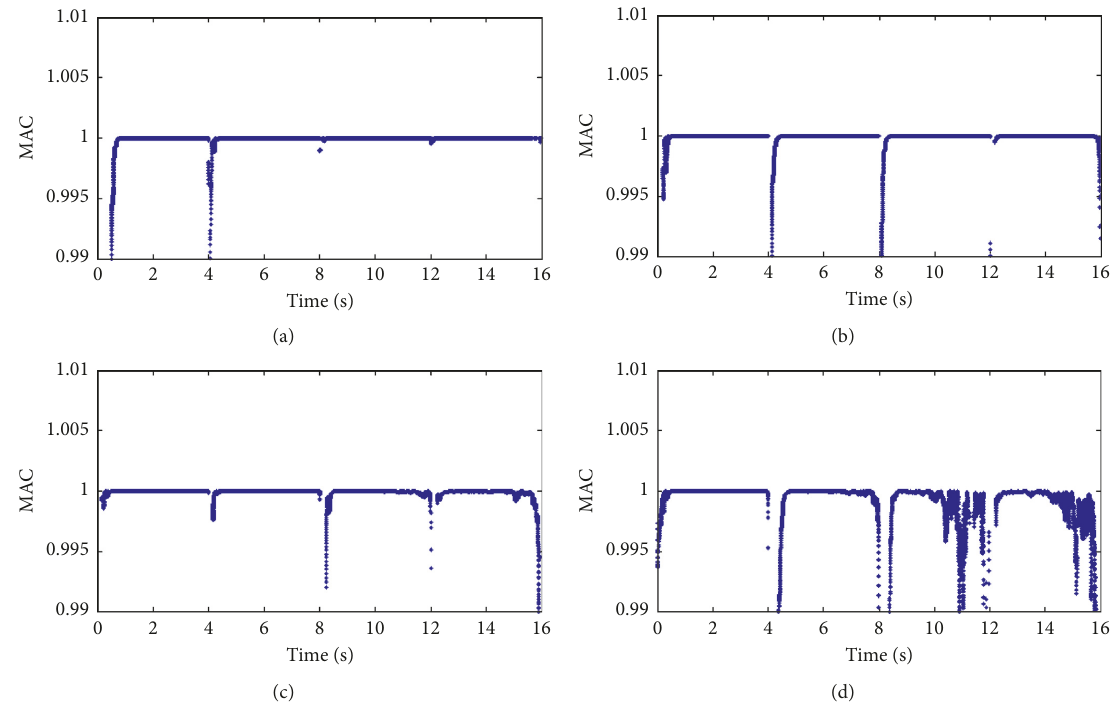
Figure 13: The MAC between the identified and theoretical values of the modal shape vectors for simulation case 1 (SNR � 40dB): (a) mode 1; (b) mode 2; (c) mode 3; (d) mode